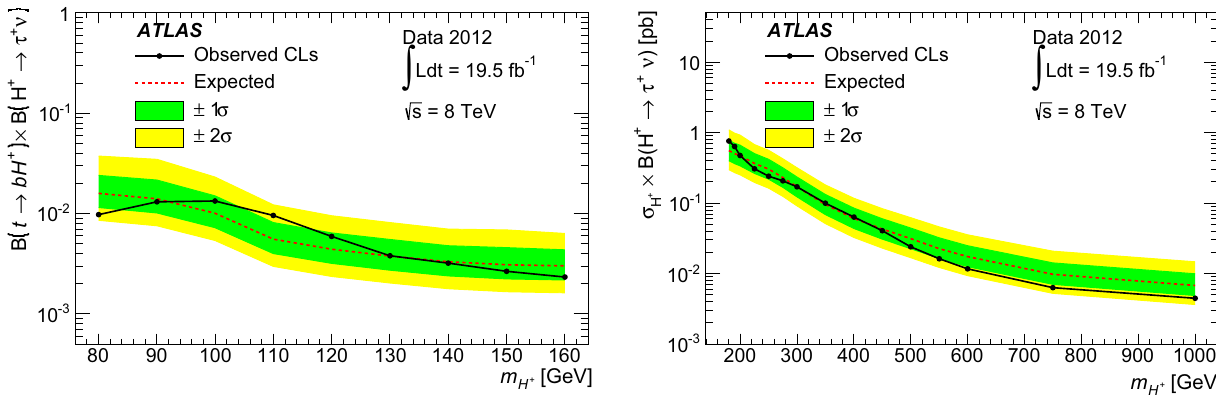
Fig. 22 ATLAS upper limits on the production and decay of low-mass ( left ) and high-mass ( right ) charged Higgs bosons. (Reprinted with kind permission from JHEP and the authors, Fig. 7 of [218])